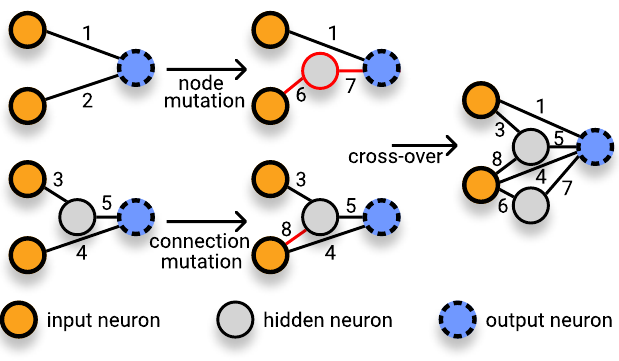
Figure 1: In the NEAT algorithm, a population (set) of neural networks undergo a series of mutation, selection and reproduction processes repeated over several gen- erations (optimization steps). The mutations involve randomly changing the values of the network parameters (with some probability) as well as randomly modifying the architecture of the network by adding / removing hidden neurons or connections between neurons (with some probability). For structural mutations, hidden neurons are always added by splitting an existing connection, and the set of input and output neurons are left untouched. Each generation also selects part of the population for crossover, without which the optimization would be purely reliant on random mu- tations. Each connection is assigned a unique number (a "genome marker"), which enables a cross-over procedure where two networks of distinct architectures can be meaningfully combined into a new network. See Appendix A for more